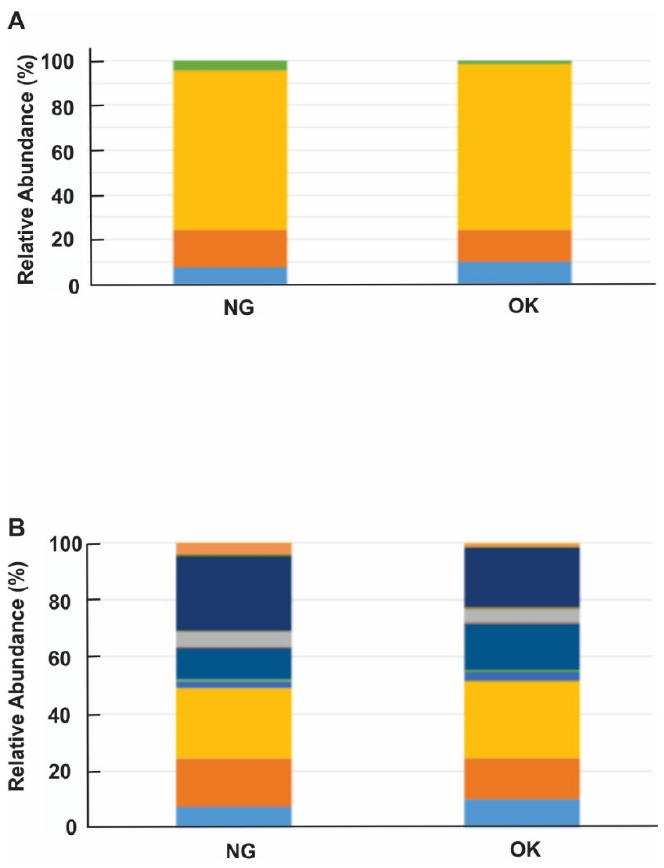
Figure 4. Stacked bar plots of relative abundance of bacterial ( A ) phyla and ( B ) order. (A)